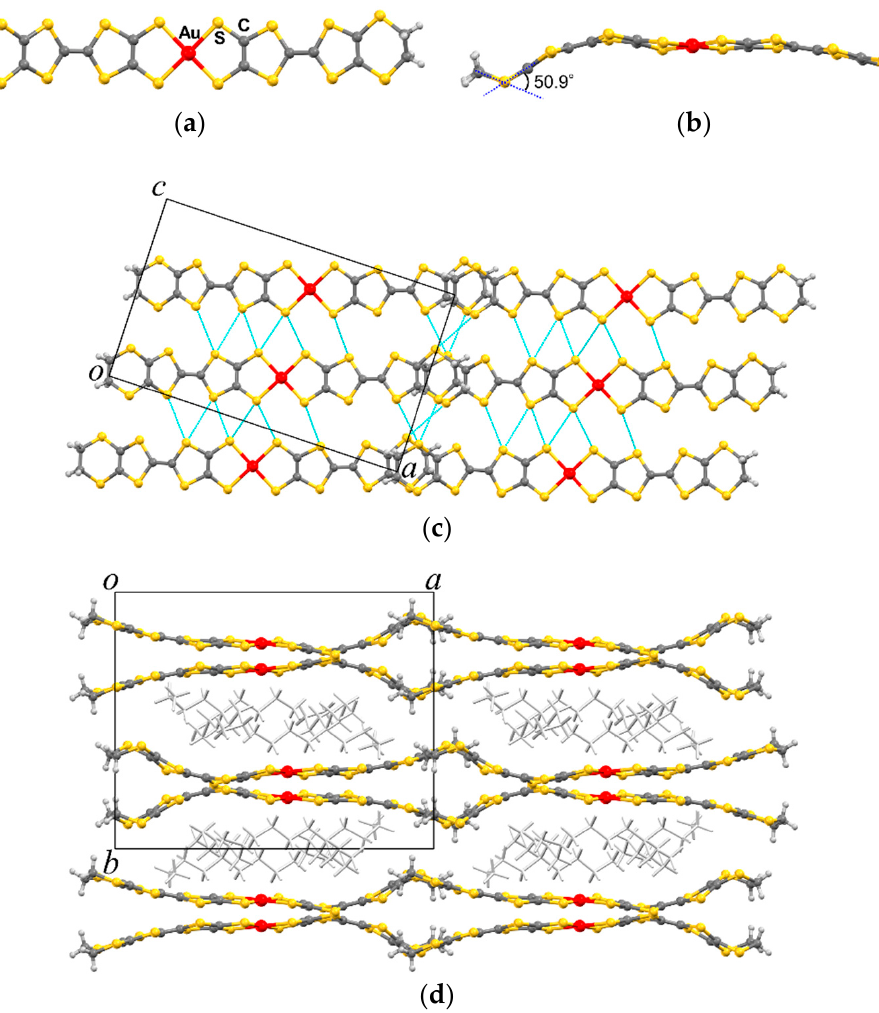
Figure 1. ( a ) Top view of the [Au(etdt) 2 ] − anion. ( b ) Side view of the [Au(etdt) 2 ] − anion. ( c ) Crystal structure of 1 viewed along the b -axis. The short S ··· S contacts ( < 3.7 Å) are shown as dotted line. The bulky tetra-n-butylammonium cations are omitted for clarity; ( d ) Crystal structure of 1 viewed along the c -axis.